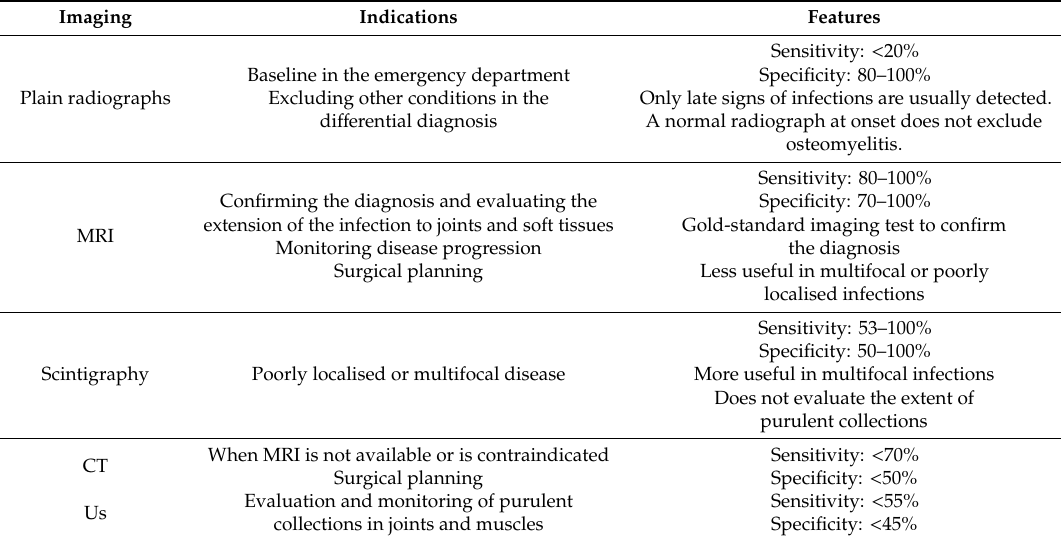
Table 2. Indications and features of imaging methods in bone and joint infection in pediatric age. Imaging Indications